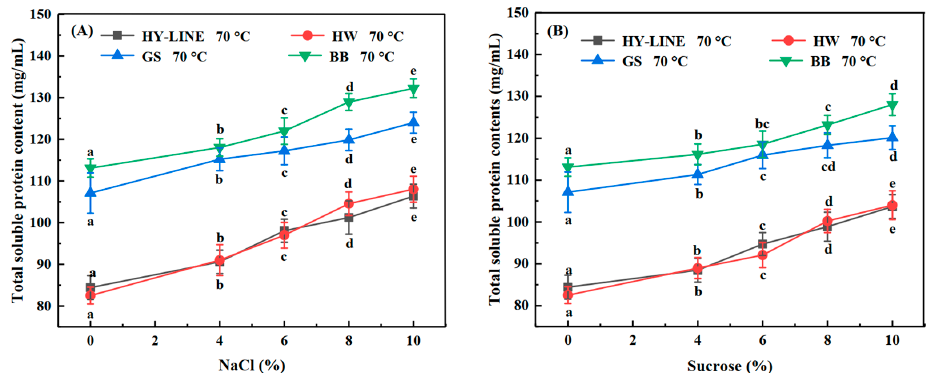
Figure 1. Total soluble protein content of four varieties of EWP subjected to heat treatment. ( A ) Total soluble protein content of four varieties of EWP with different NaCl concentrations after heat treatment. ( B ) Total soluble protein content of four varieties of EWP with different sucrose concentrations after heat treatment. Three replicate samples were measured for each treatment.